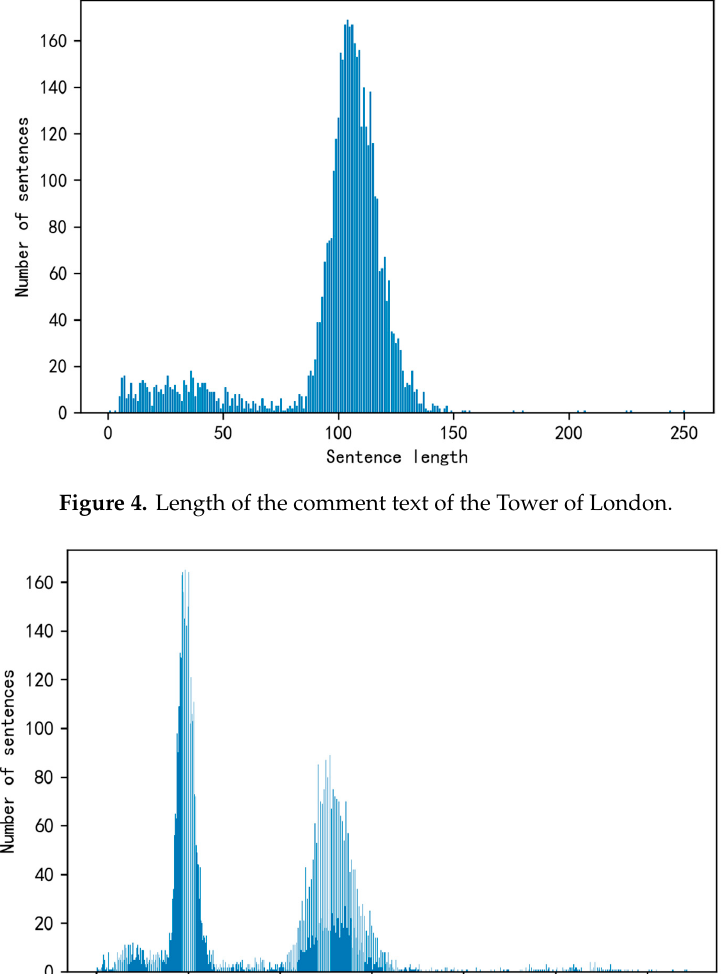
Figure 3. Length of the comment text in the Harry Potter Wizarding World Theme Park in Orlando, USA.